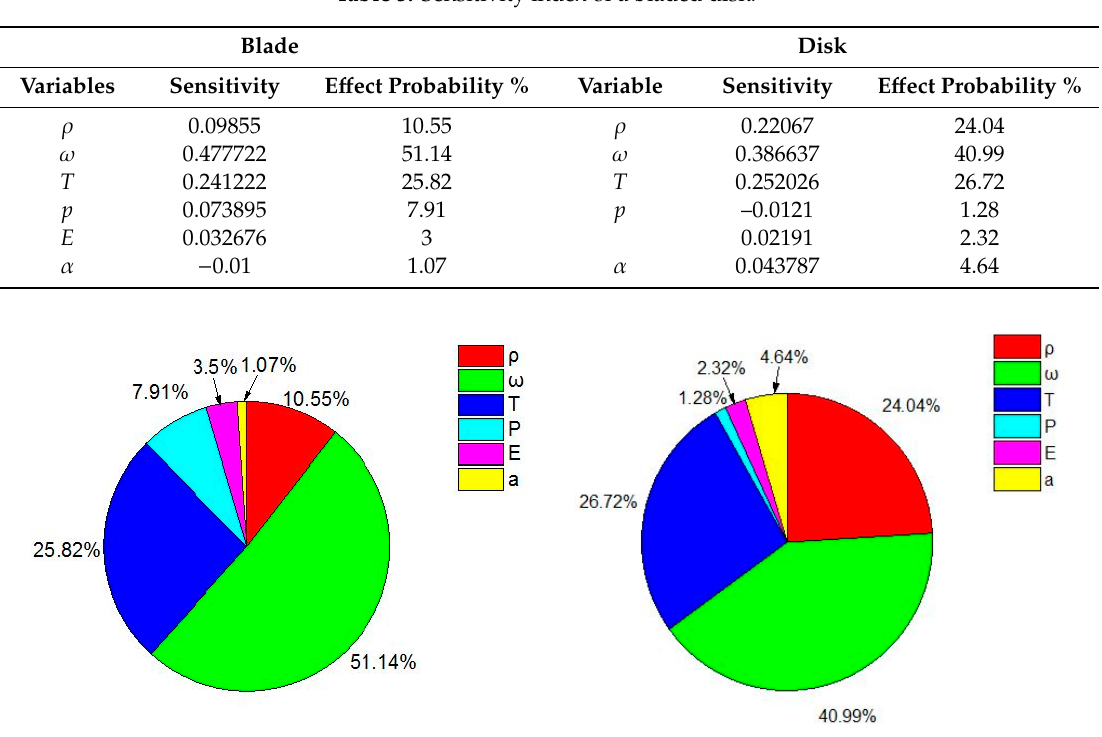
Figure 9. Sensitivity indexes of parameters on bladed disk coupling failure.